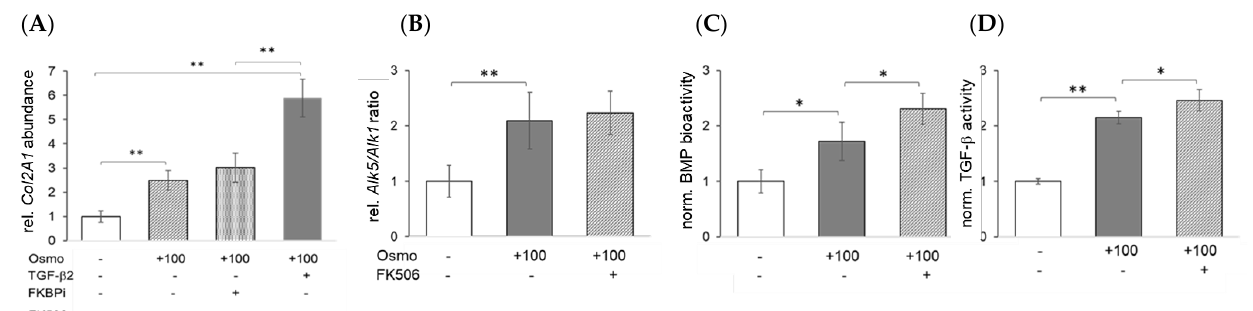
Figure 7. Modulation of collagen expression by FK506 is calcineurin and TGF- β dependent. ( A ) Col2a1 mRNA expression (n = 5) and ( B ) Effect of osmolarity and FK506 on the mRNA expression ratio of ALK5/ALK1 (n = 3), and on ( C ) BMP- and ( D ) TGF- β bioactivity, respectively, in chondrocytes (n = 3); *, p < 0.05; **, p < 0.01.